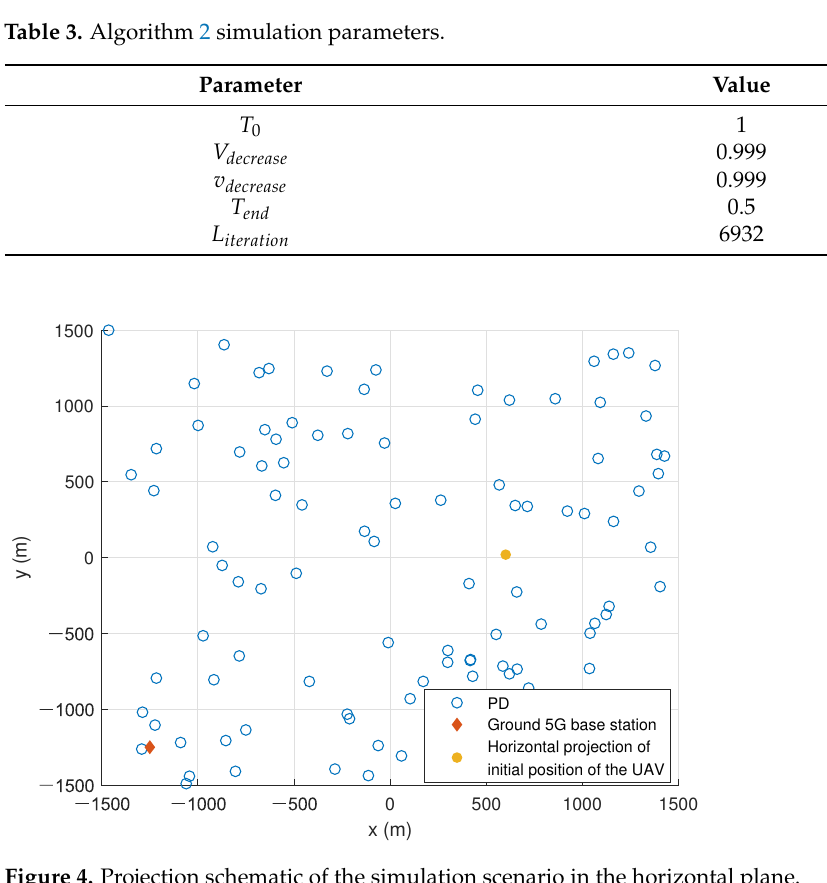
Figure 4. Projection schematic of the simulation scenario in the horizontal